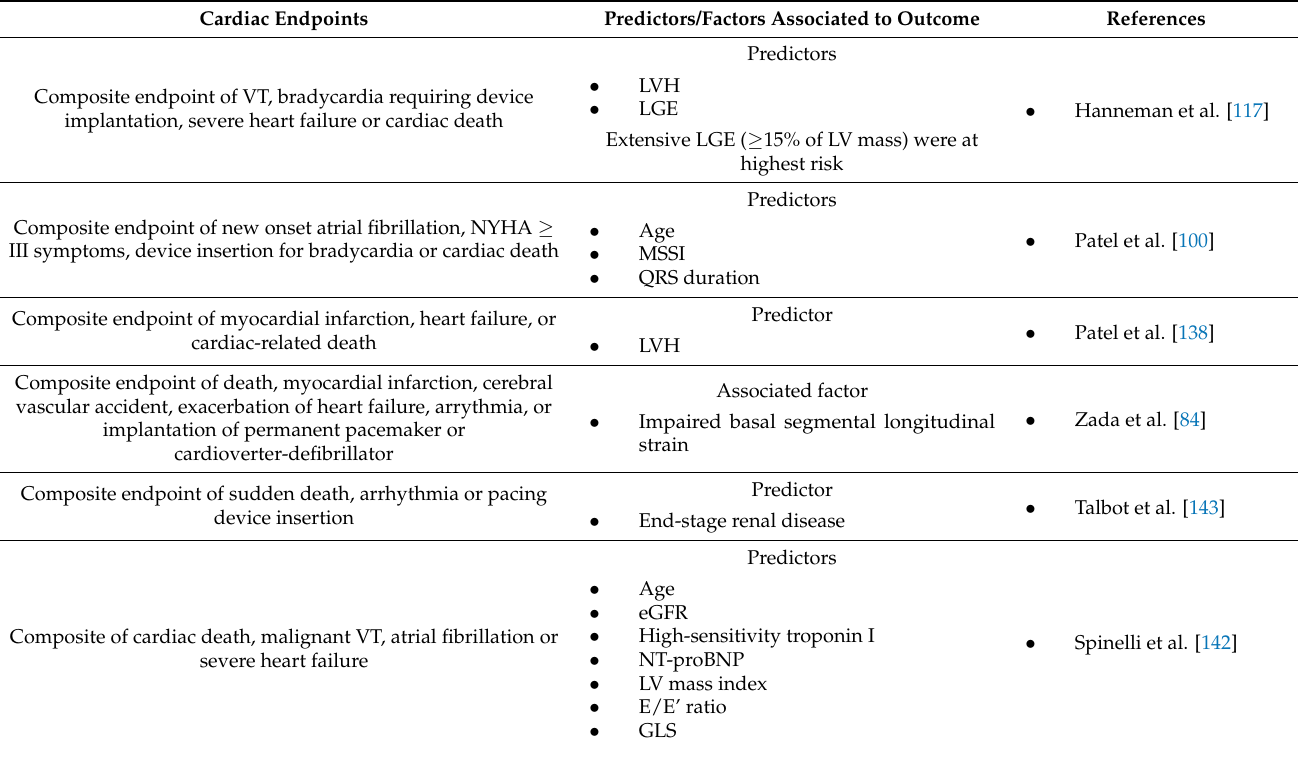
Table 5. Predictors/Factors associated to cardiac events in